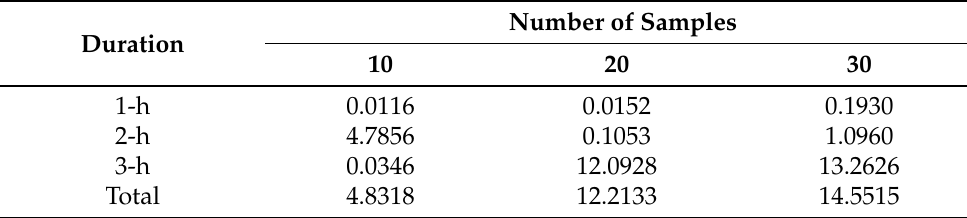
Table 4. Optimal building costs for BESSs with different numbers of samples ($